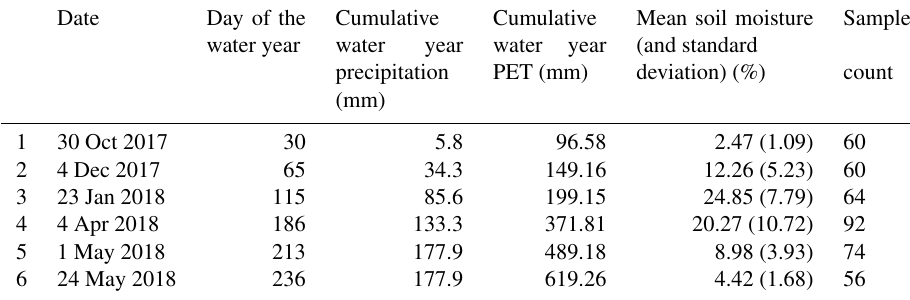
Table 3. Data collection days and site summary